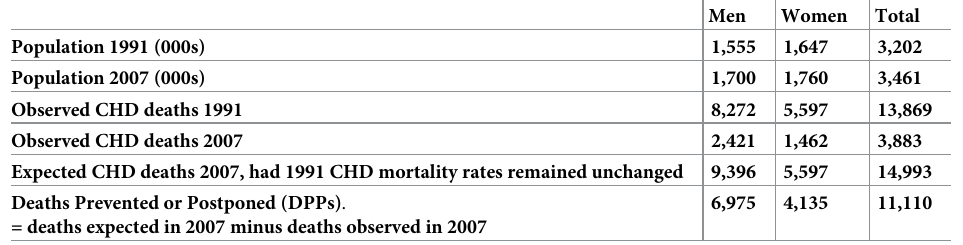
Table 1. CHD mortality in 1991 and in 2007, and deaths prevented or postponed in Danish men and women in 2007.